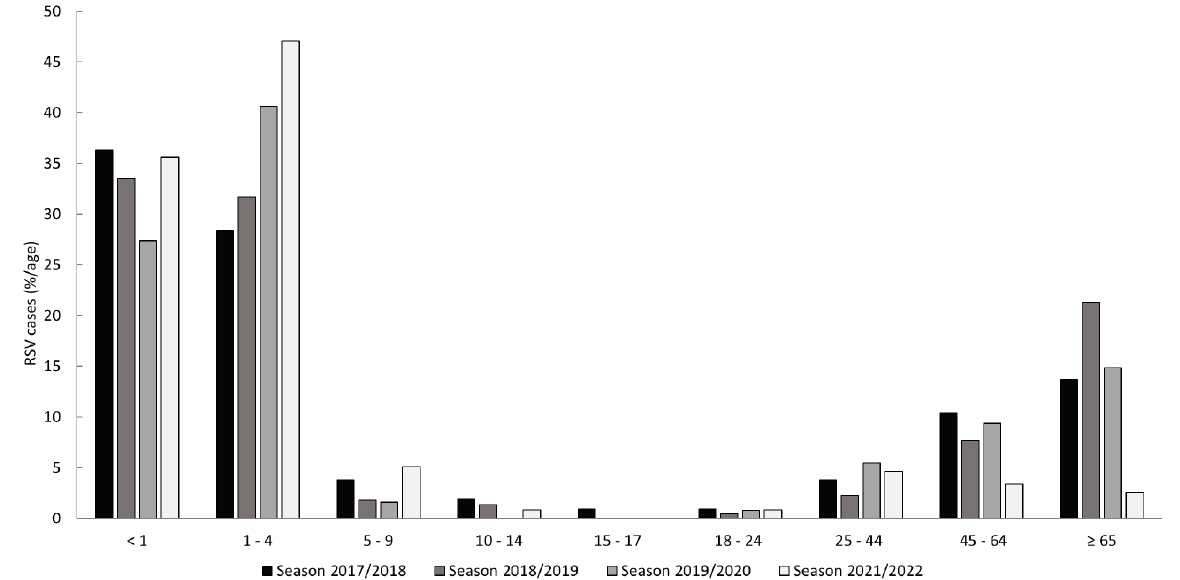
Table 1. Gender, age, and RSV species distribution during the study period.